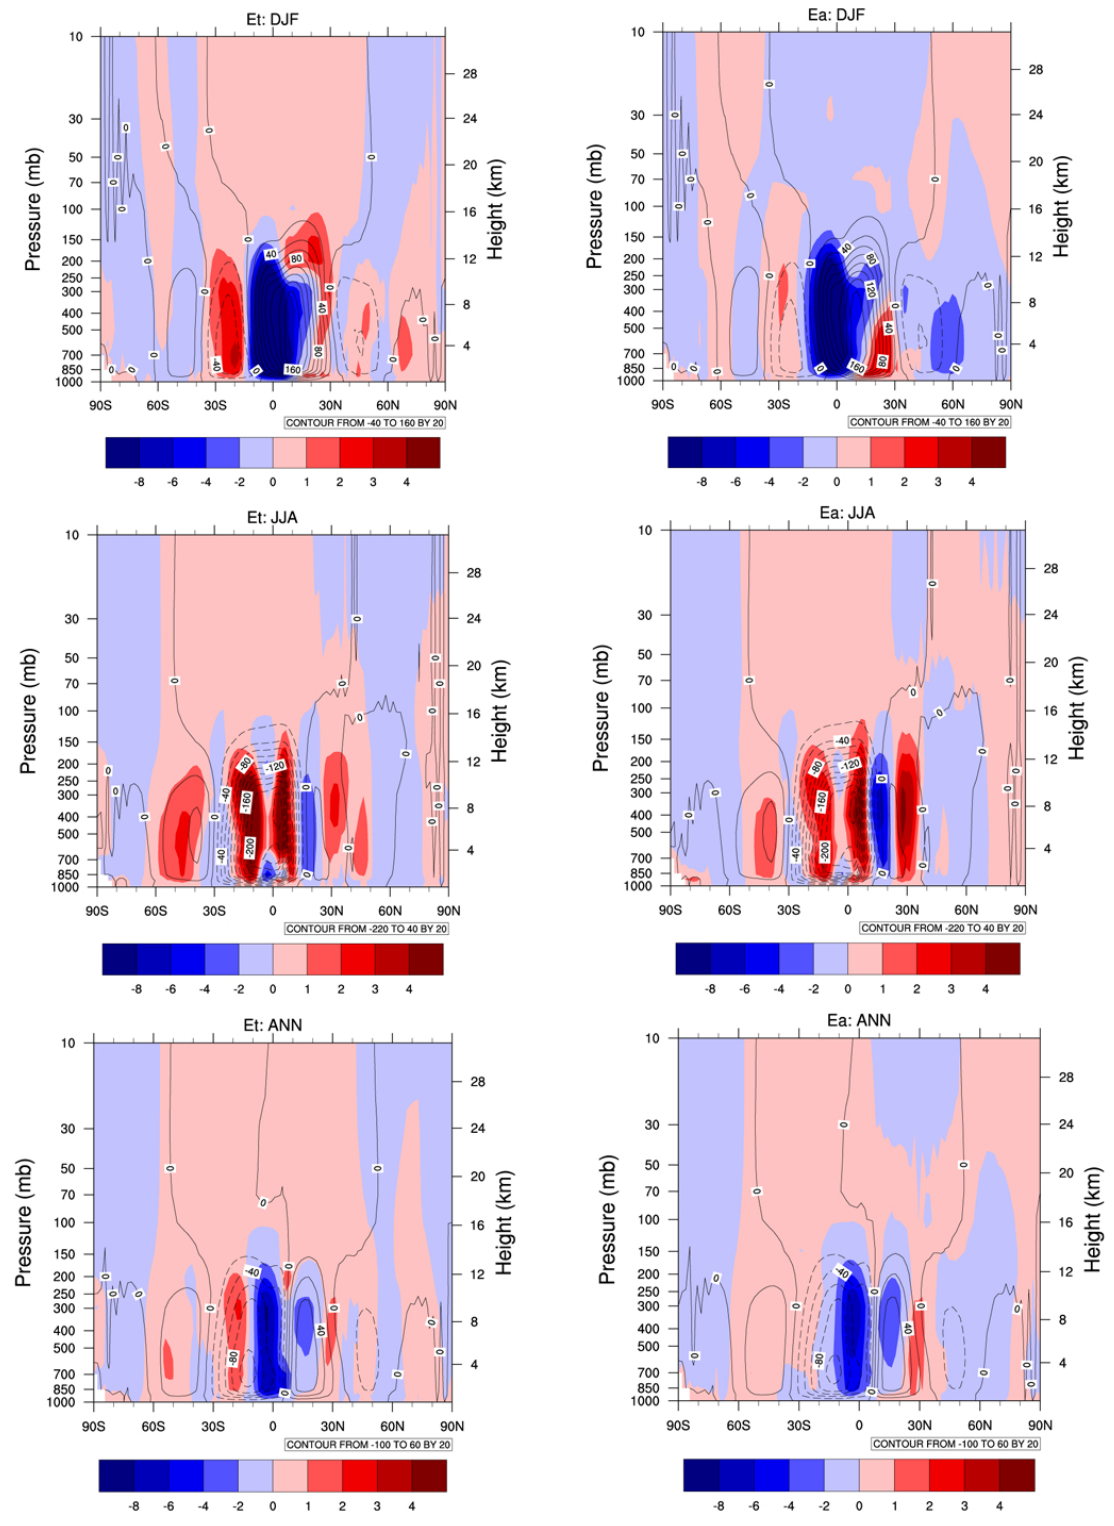
Fig. 9. Et and Ea of mean meridional circulation shown in color shades. The line contours represent climatology for the no-carbon runs. The solid lines stand for positive values of MMC and dash lines represent negative values of MMC. Unit is 10 9 kgs − 1